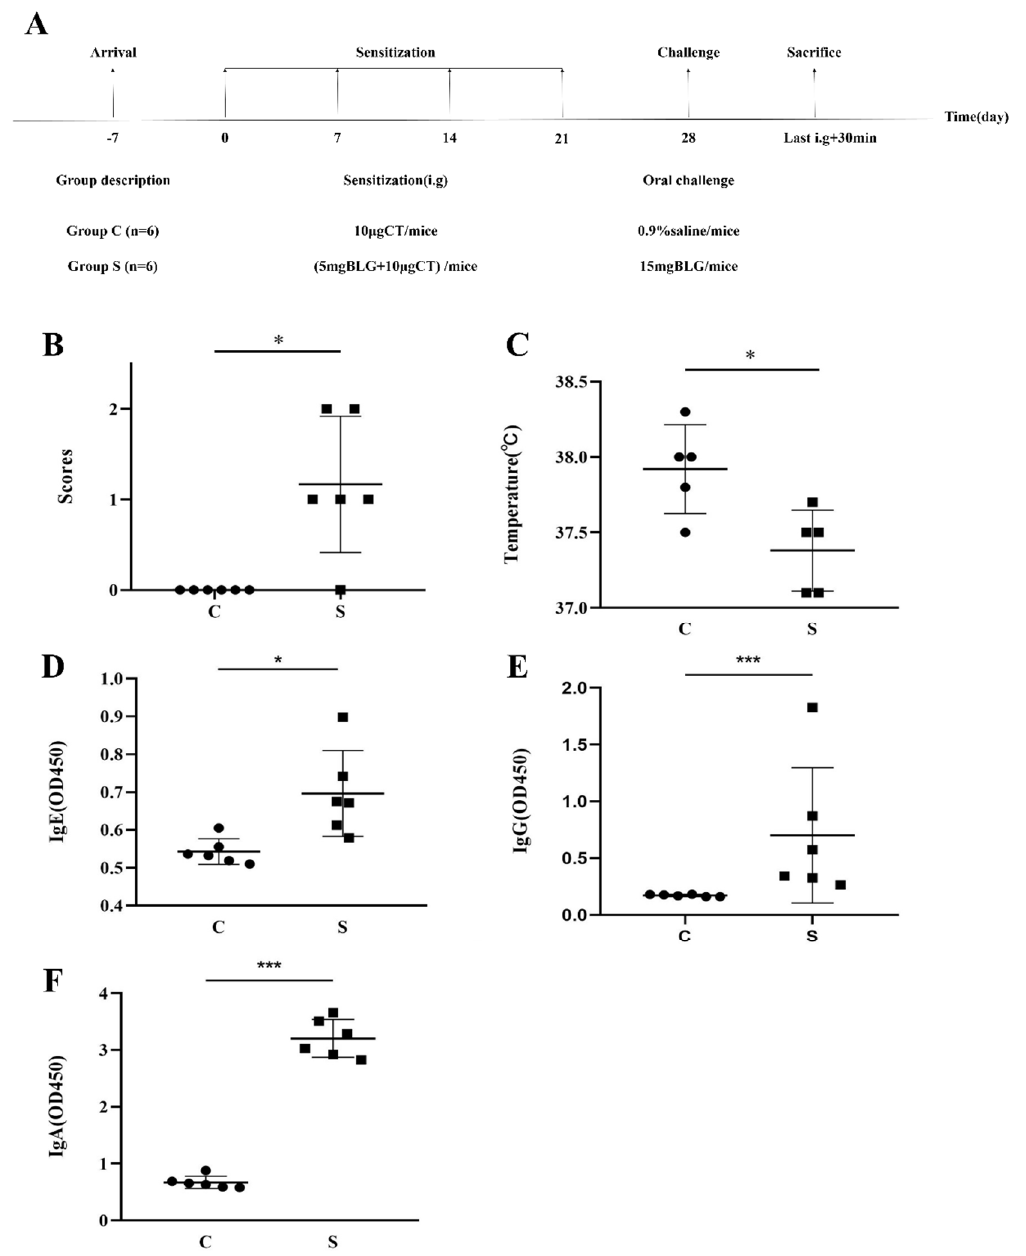
Figure 1. Animal experimental design and effects of eliciting dose on the allergic symptoms. ( A ) Protocols of oral administration of Balb/c mice with bovine BLG. The scores of clinical symptoms ( B ) and body temperature ( C ) were observed during 30 min after the last oral challenge. Specific antibody levels of BLG−specific IgE ( D ), IgG ( E ), and IgA ( F ) were measured by ELISA. The results are represented as the mean ± SD ( n = 6, each point (round and square) represents data from an individual mouse; the data were calculated in three replicates; * p < 0.05, *** p < 0.01, as determined by one − way analysis of variance (ANOVA) with Duncan’s